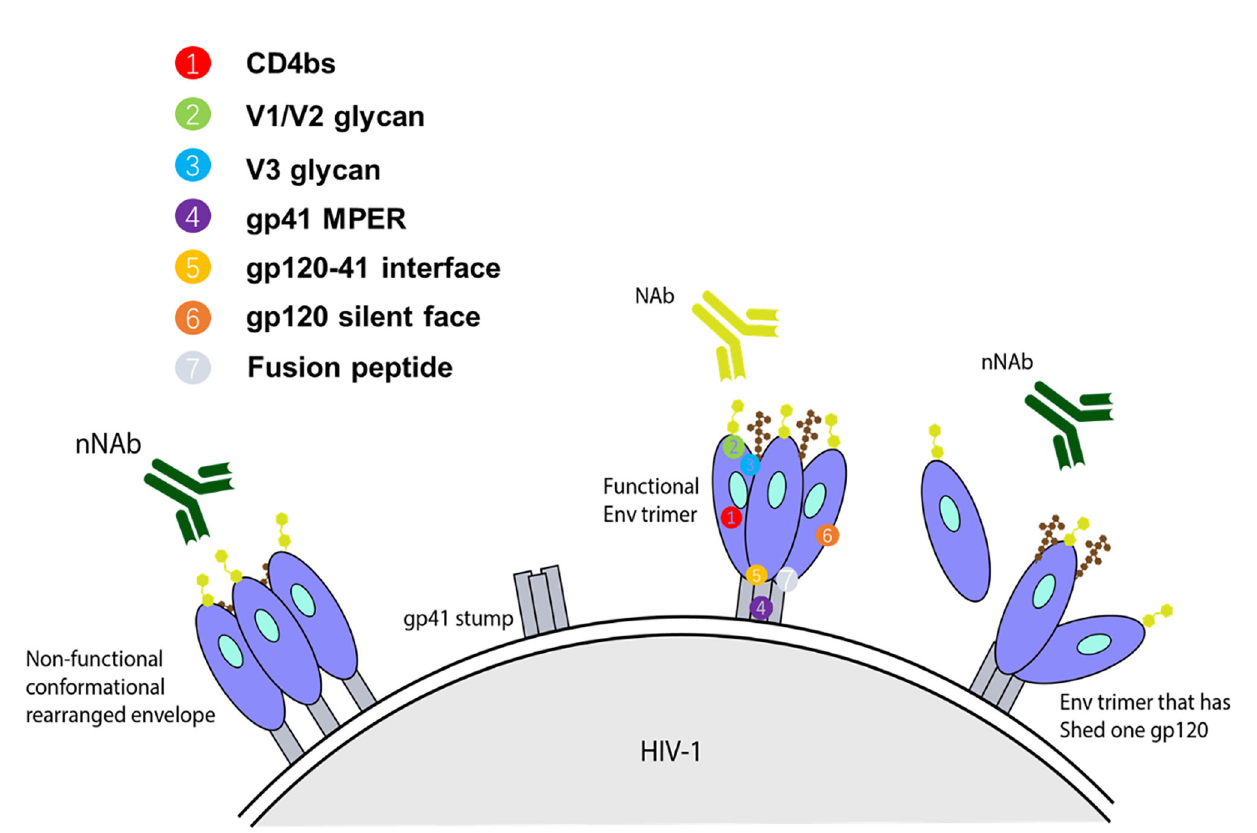
FIGURE 1 | Representation of some forms of Env targets present on infecting HIV-1 strain and available to elicit their respective class of antibody response. For an anti-HIV-1 antibody to have neutralizing activity, it should interact with functional spikes on Env trimers that mediate HIV-1 entry into target cells (38, 39). Non- neutralizing antibodies typically target Env epitopes absent from the functional spikes of the native Env trimer (39, 40). The targets for autologous nAbs are V loops and other regions of gp120 with relatively high sequence variation on functional spikes between strains, and therefore, they can only bind Env trimers from the infecting strain. Heterologous bNAbs on the other hand typically target the relatively conserved regions, based on sequence or amino acid homology, with some targeting the variable loop. Collectively, the known spectrum of bNAb targets encompass the CD4bs, glycan dependent epitopes V1/V2 and near the base of V3/C3, linear epitopes in the membrane proximal external region (MPER) of gp41, gp120-41 interface, gp120 silent face, and fusion